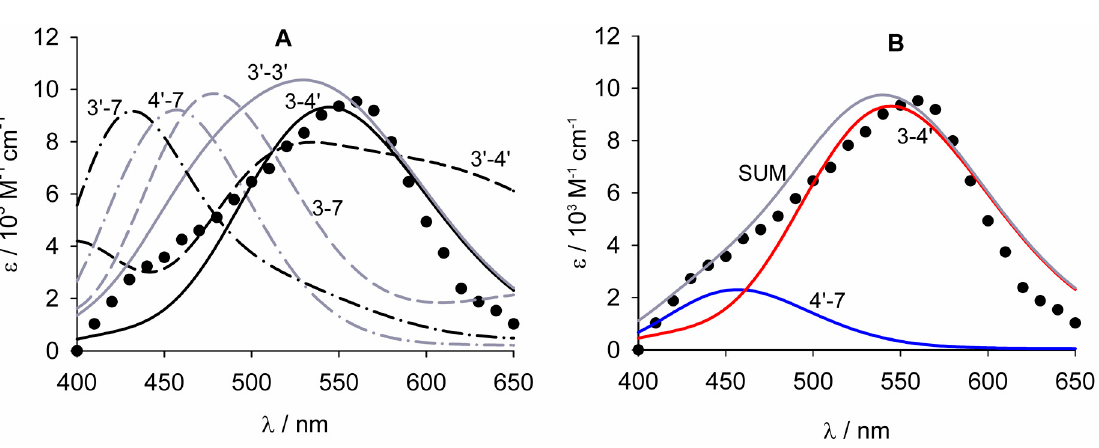
Figure 4. Relative stability of the radical anions obtained by H-atom abstraction from deprotonated quercetin, calculated in the gas phase ( A ) and in water ( B ), determined from the relative energy ( E rel ) with reference to the most stable species (ref = 0). Numbers on the x -axis indicate the position of the radical and of the negative charge. The radical anion in 5-7 is omitted for clarity ( E rel is 32.7 and 21.0 kcal/mol in the gas phase and water, respectively).